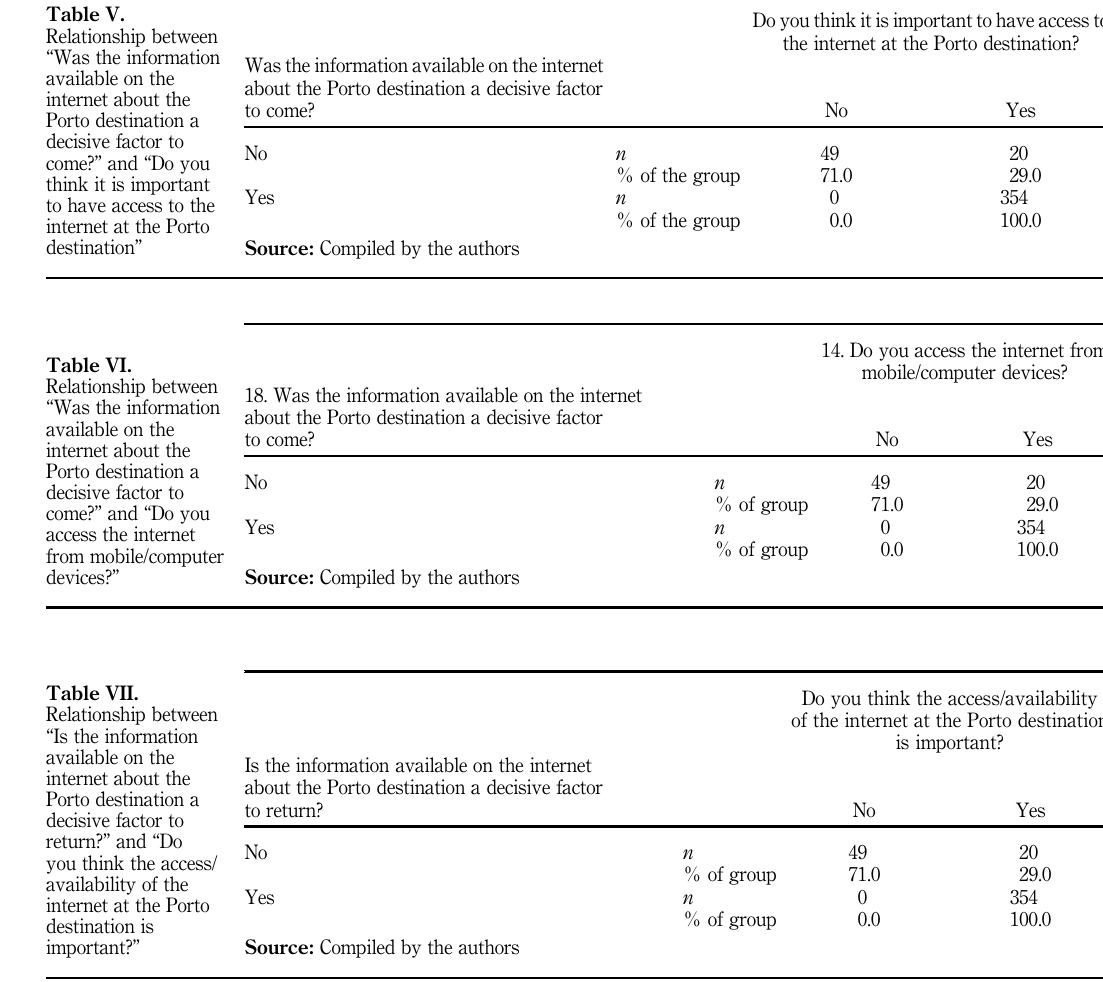
“ Is the information available on the internet about the Porto destination a decisive factor to return? ” and “ Do you think the access/ availability of the internet at the Porto destination is important?